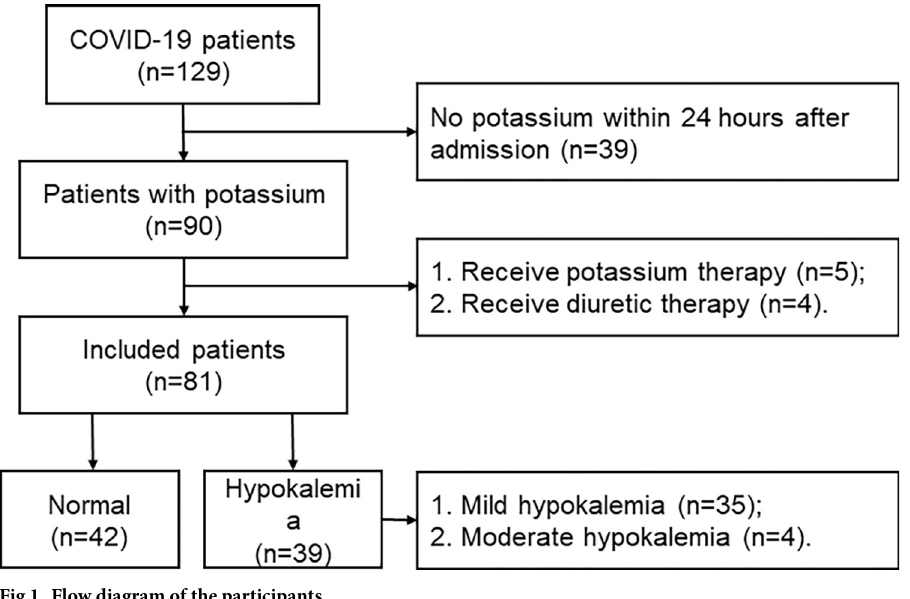
Fig 1. Flow diagram of the